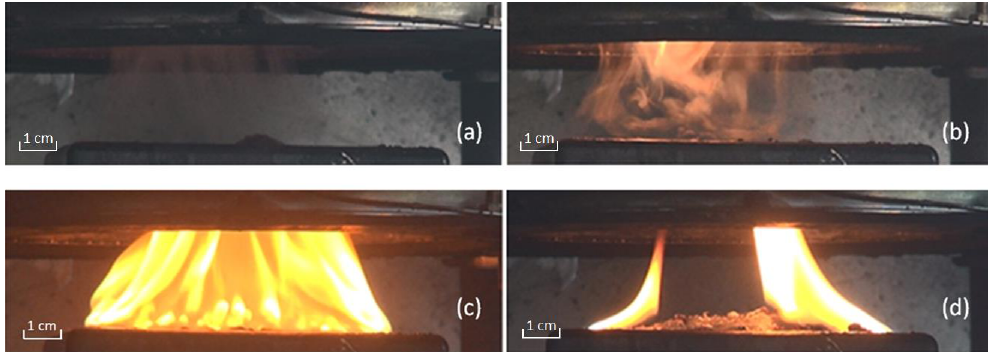
Figure 3. Burning process of CIGS specimen. ( a ) incipient stage; ( b ) ignition; ( c ) fully burning stage; ( d ) extinction stage.